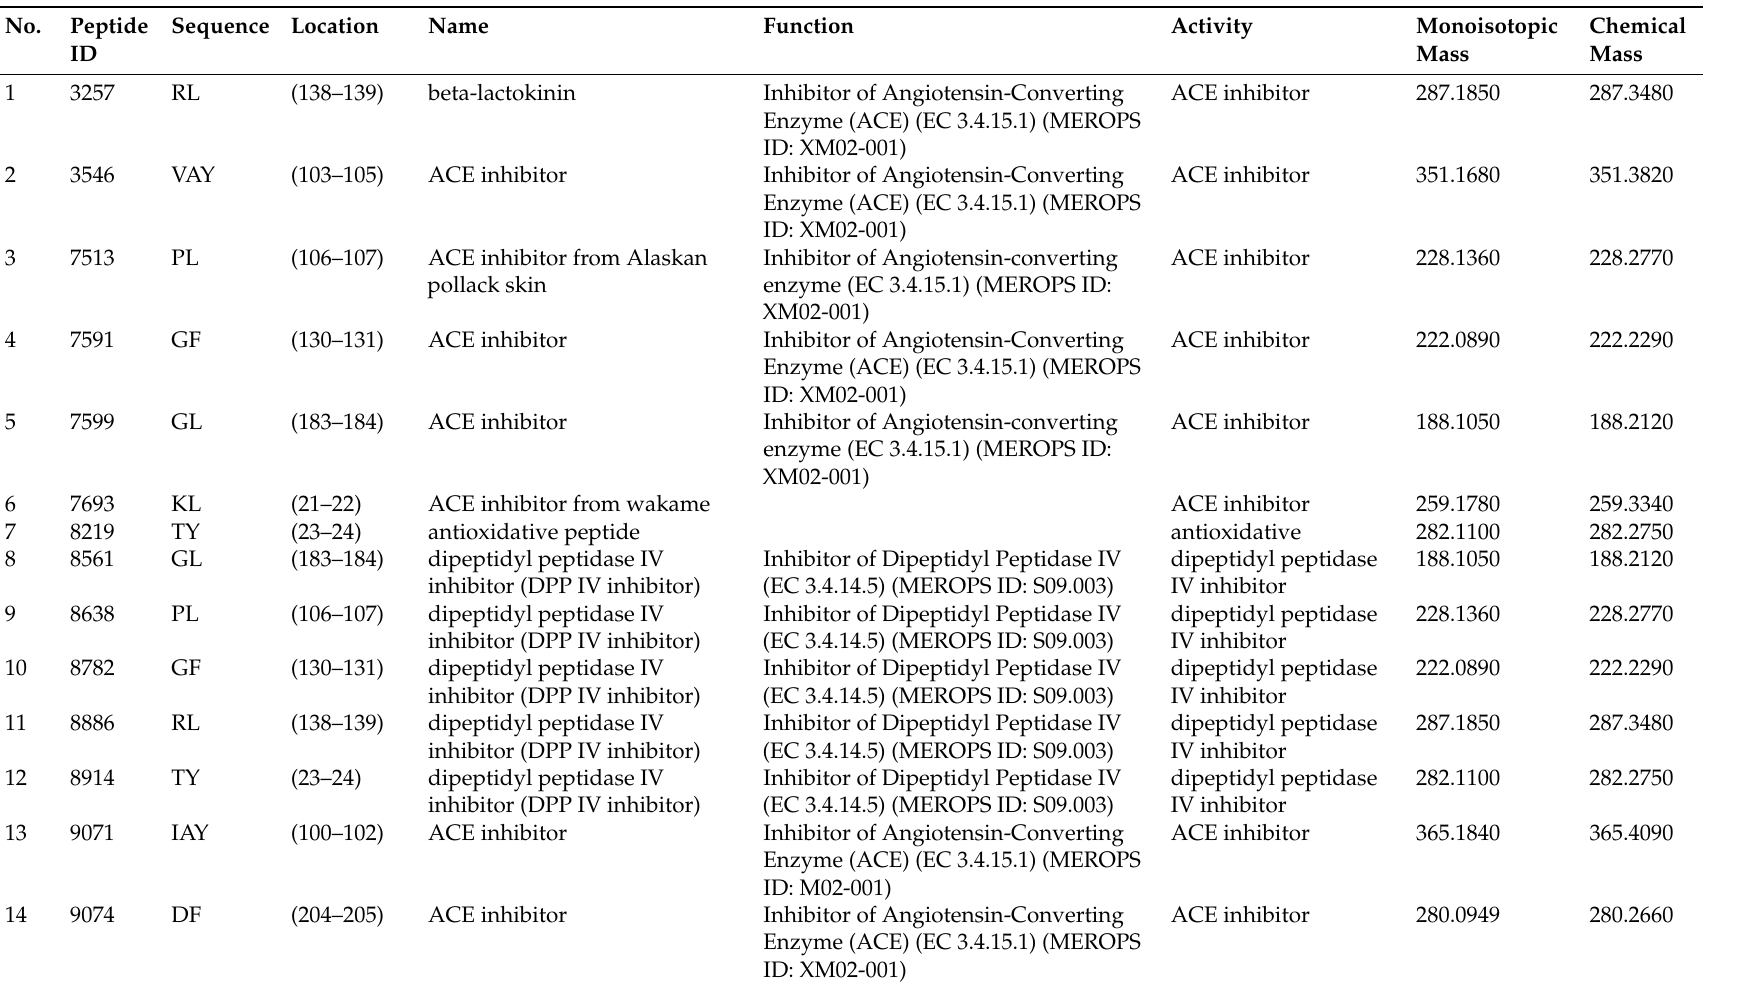
Table A21. Bioactive peptides from RubisCO of Halophila stipulacea . In silico enzymatic cleavage was carried out by using